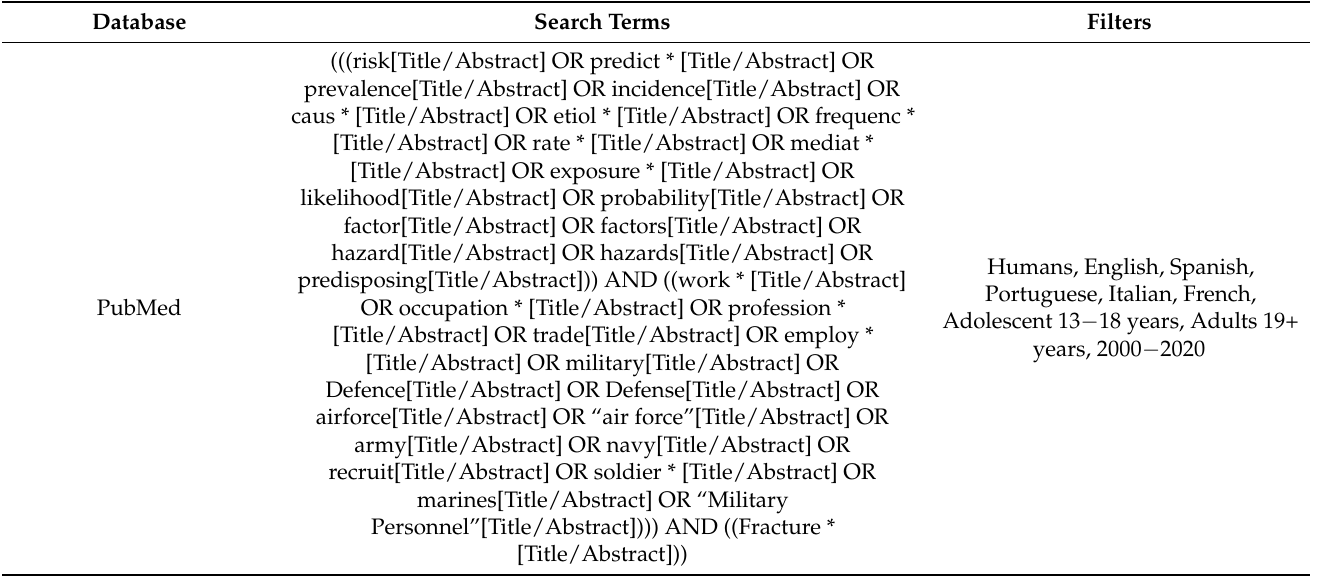
Table 1. Search terms used in